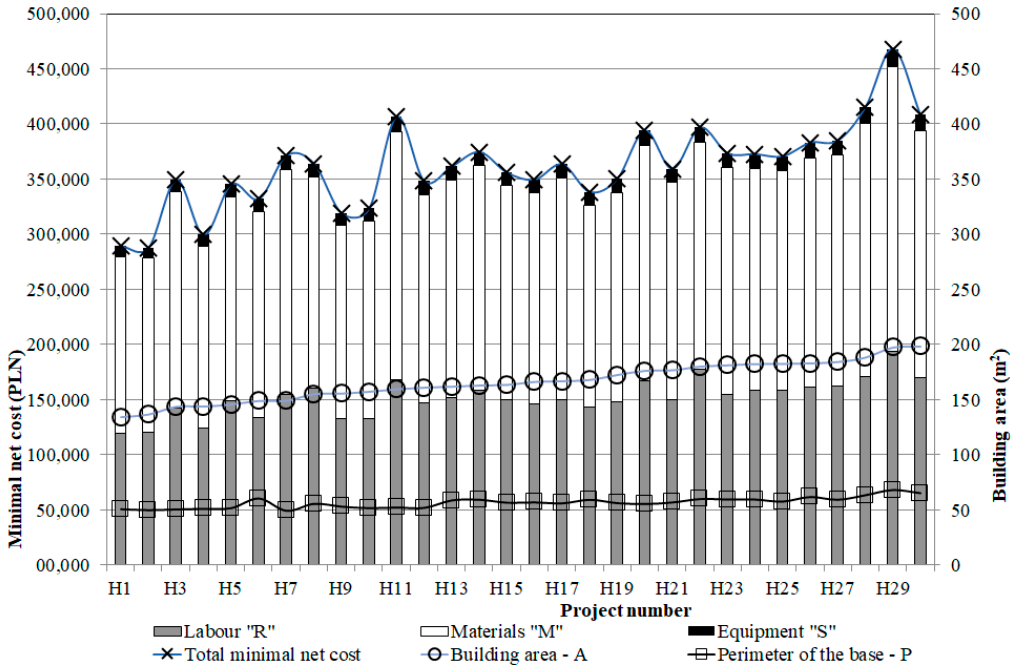
Figure 3. Summary of the share of selected materials and costs.